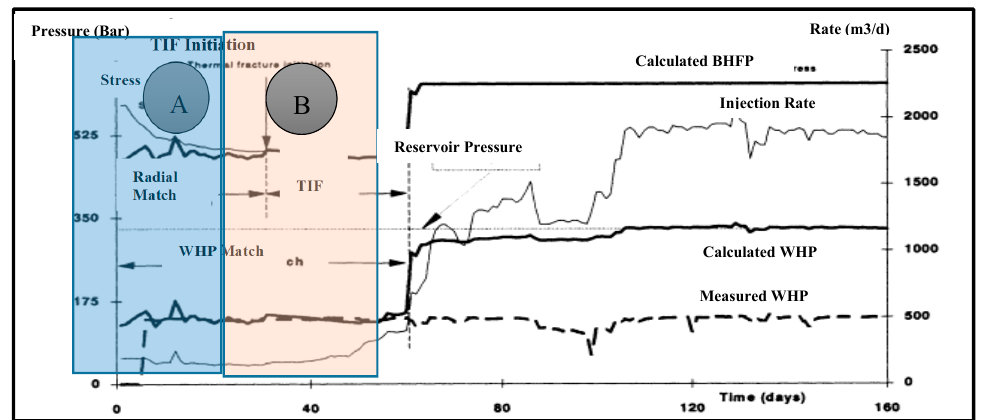
Figure 6. History match improves assuming a vertically confined thermally induced fracture (TIF) between 30 and 60 days for well A [5].